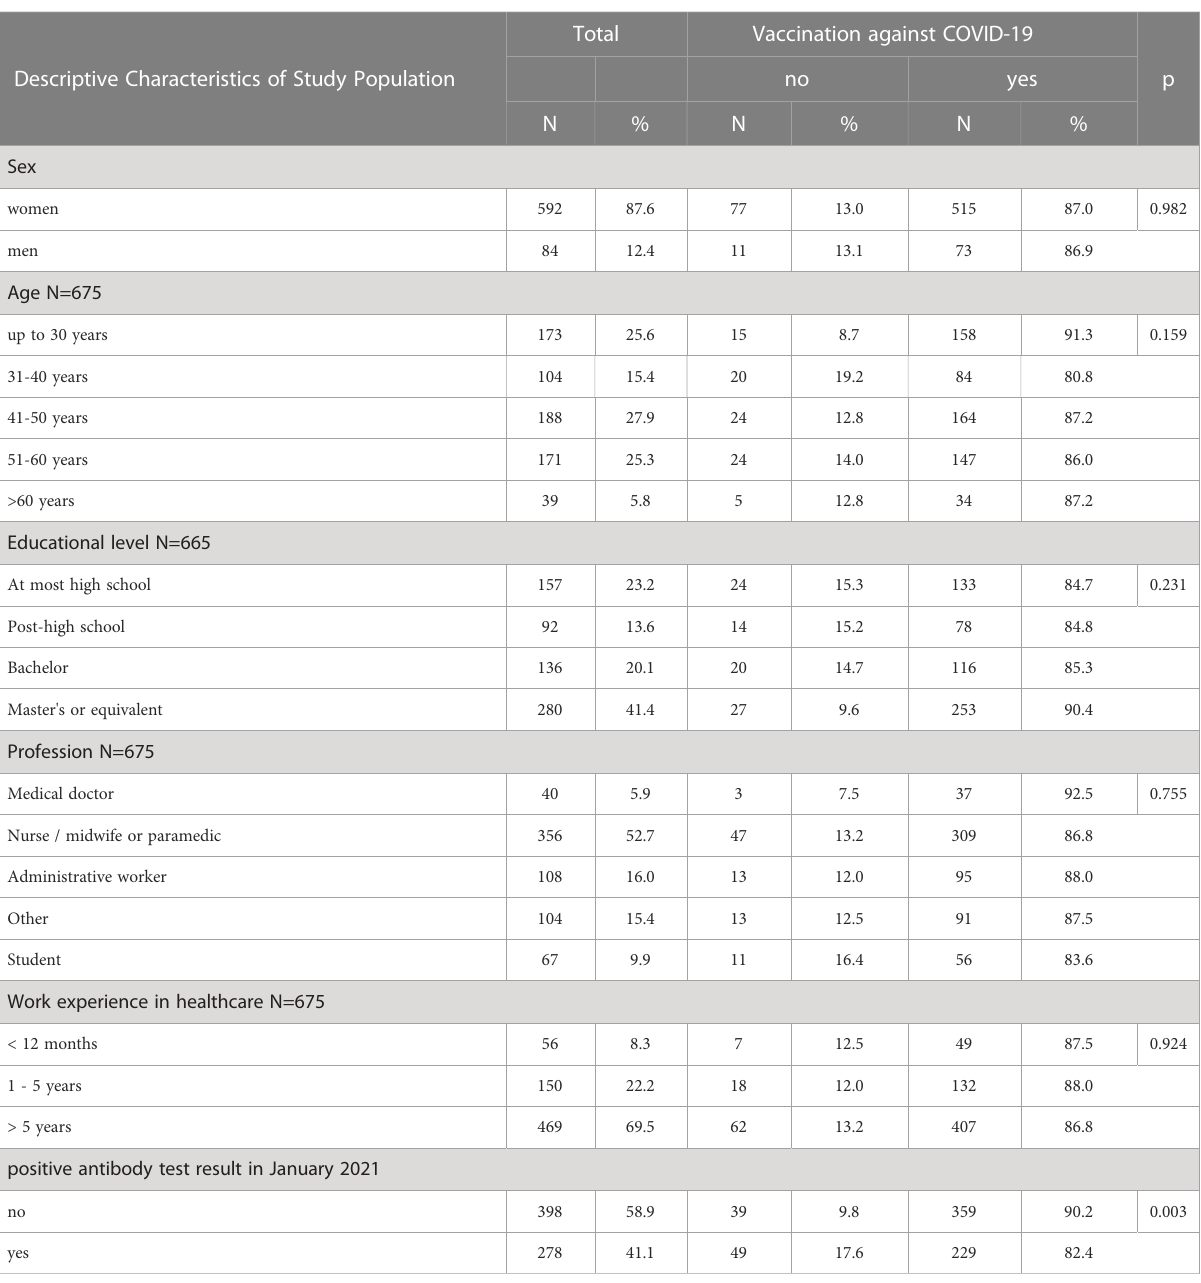
TABLE 1 Characteristics of the study